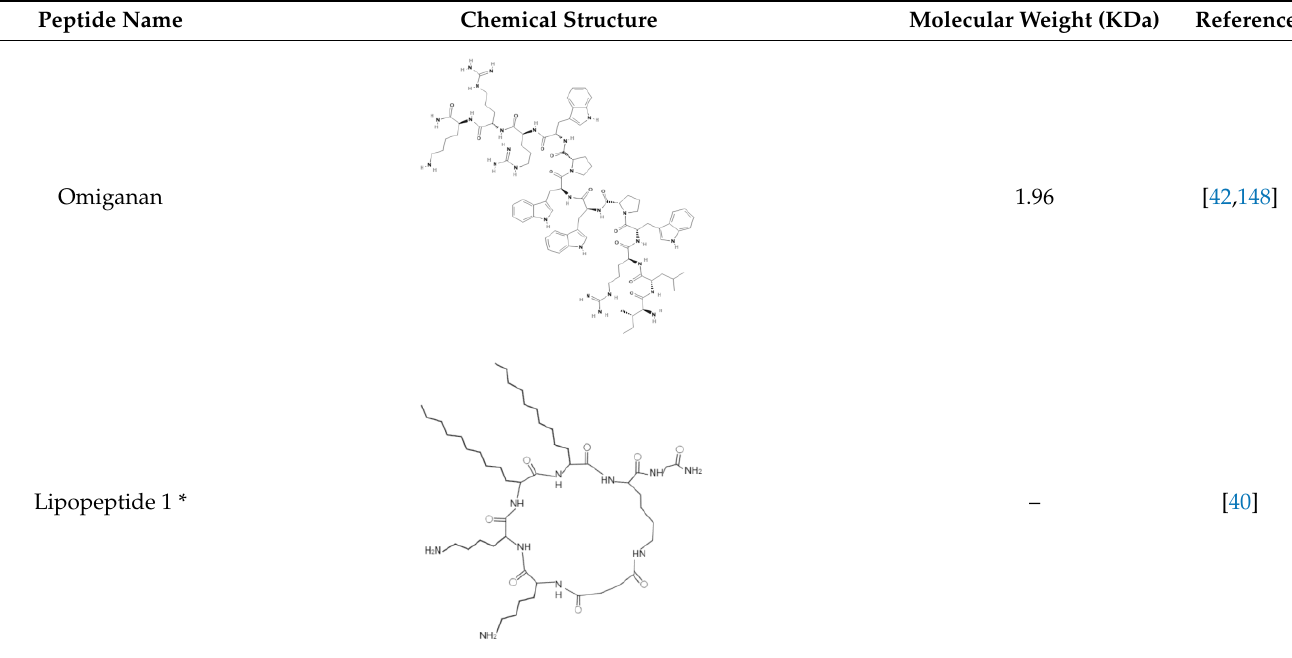
Table 7. Artificial AMPs of atypical structure that showed antibacterial activity against VRSA and VISA